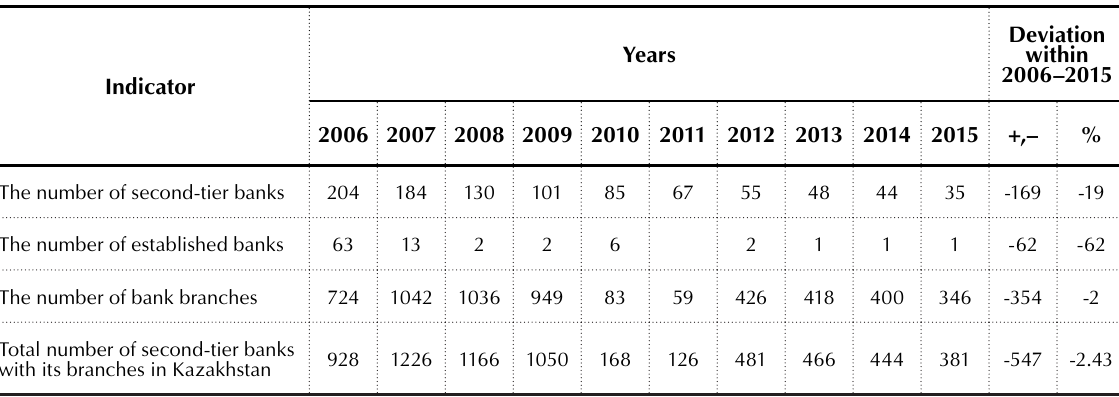
Table 2. An analysis of the growth in the number of second-tier banks in Kazakhstan